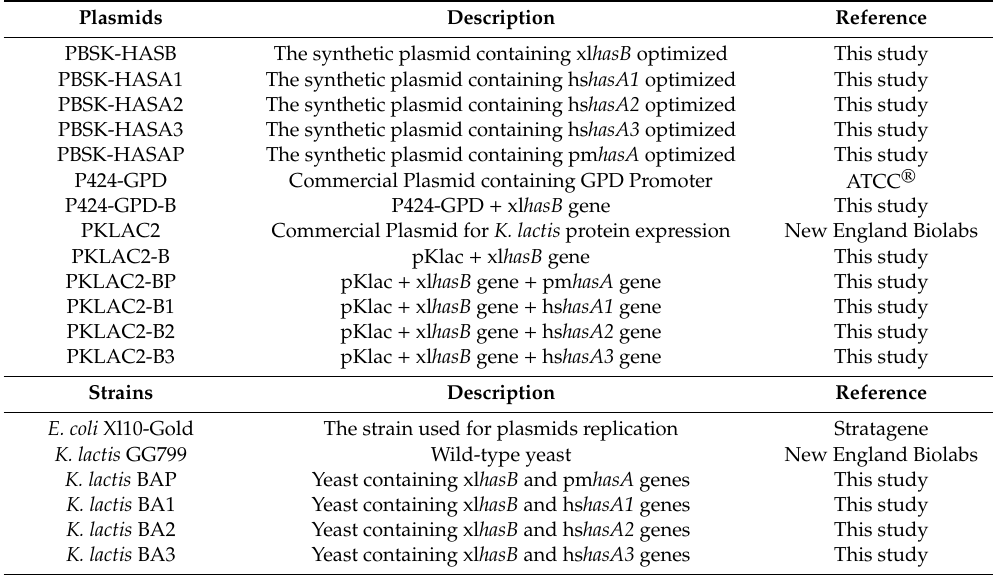
Table 1. Plasmids and strains used in this